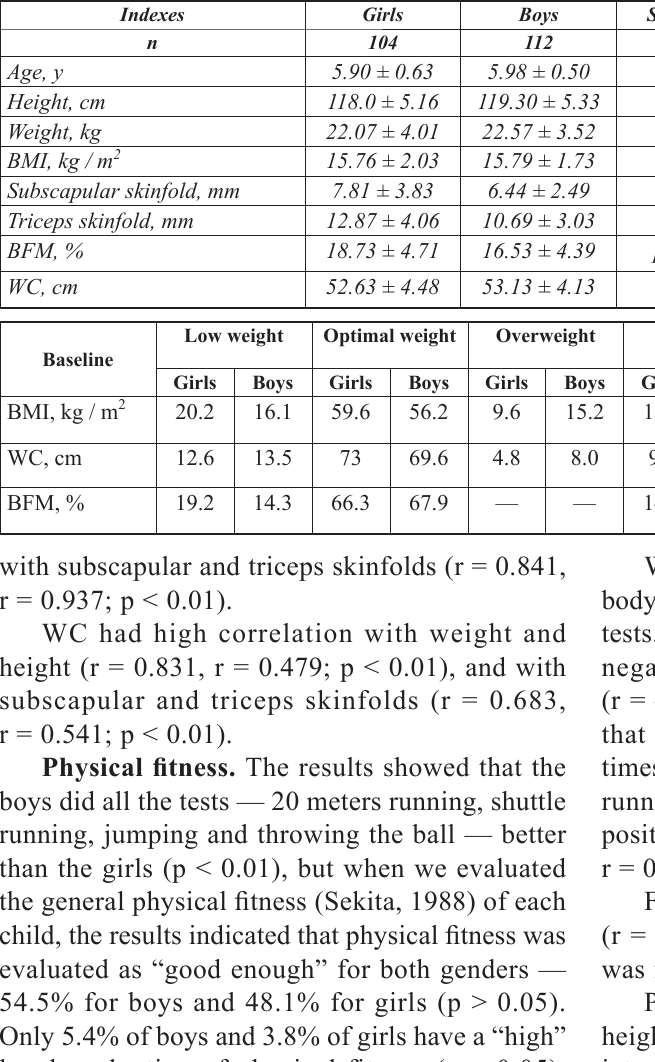
Table 1. Characteristics of subject